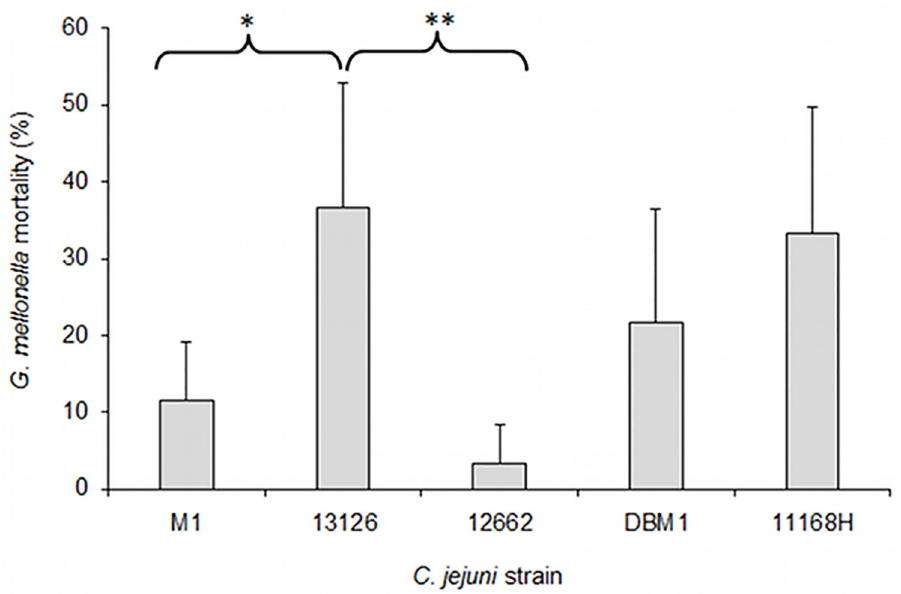
Fig 4. Mortality of Galleria mellonella larvae at 48h post infection with C . jejuni . Mortality as measured by larval viability 48 hours after challenge. Data presented based on six repeats of infection experiment using 10 larvae per isolate. Asterisks show statistically significant differences in mortality rate between C . jejuni 13126 and other strains as assessed by one-way ANOVA with Tukey post-hoc test ( * p = 0.02; ** p = 0.001).